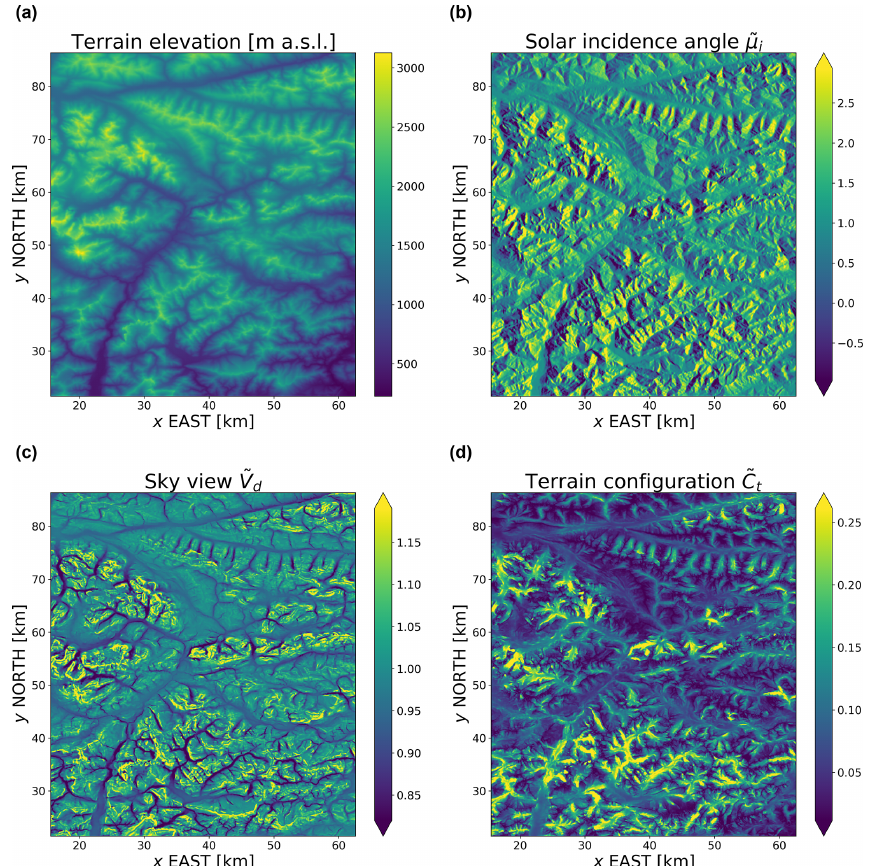
Figure 5. Terrain variables computed for the same domain shown in the previous figure (eastern Alps). Solar incidence angle was computed for µ 0 = 0 . 40, φ 0 = π/ 2. Maps are shown using an equal-area Mollweide